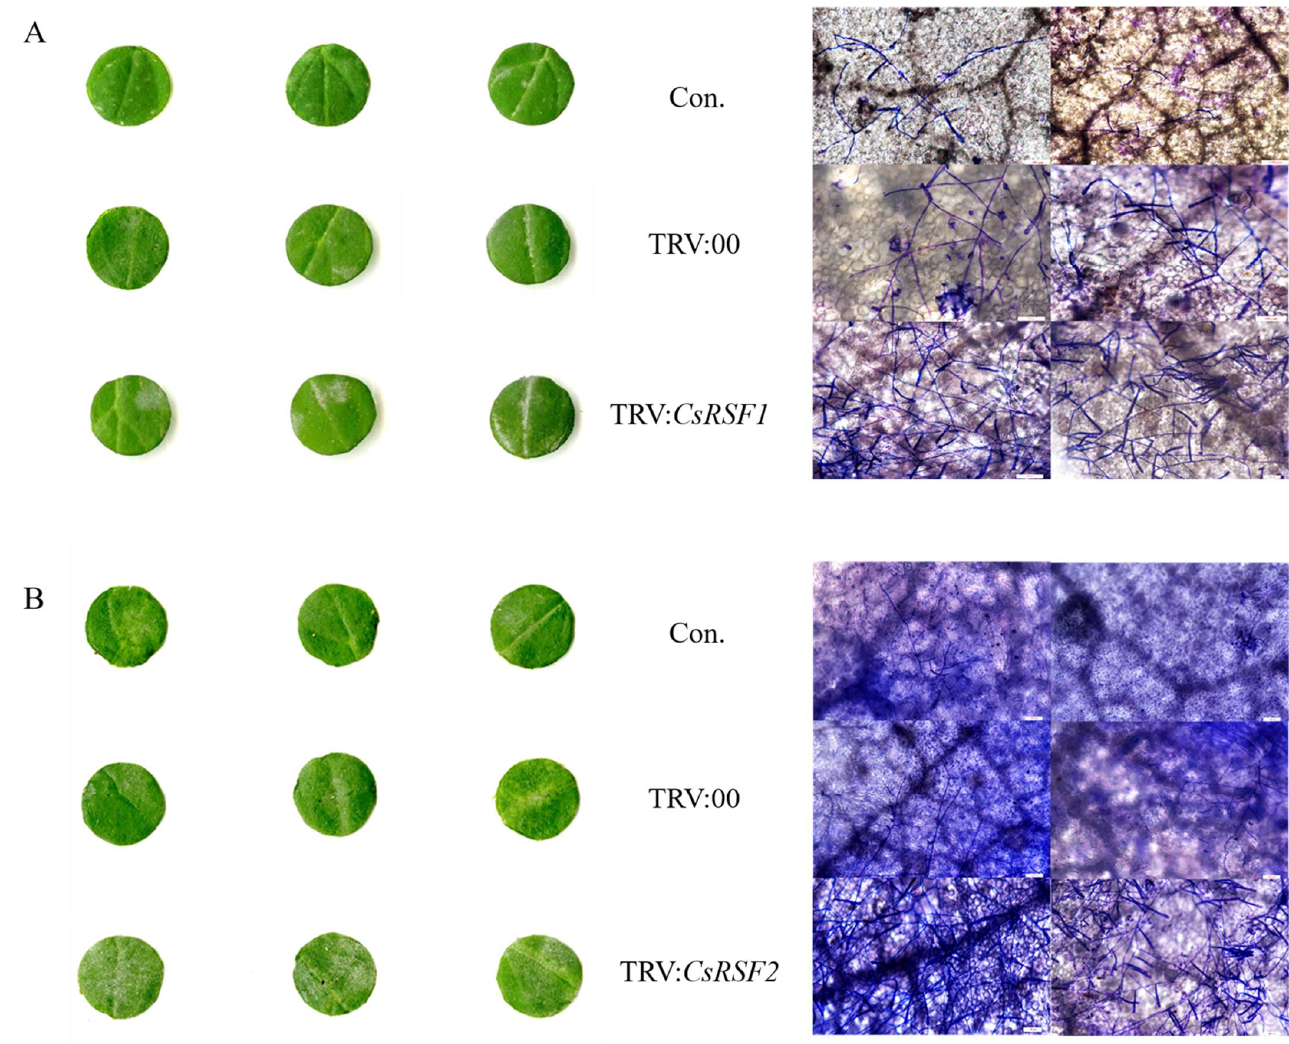
Figure 6. Identification disease-resistance of CsRSF1 / CsRSF2 - silencing plants after S. fuliginea infection. ( A ) Phenotypic analysis and Coomassie brilliant blue staining to examine CsRSF1 transient silencing cucumber cotyledons after S. fuliginea infection. ( B ) Phenotypic analysis and Coomassie brilliant blue staining to examine CsRSF2 transient silencing cucumber cotyledons after S. fuliginea infection. Con. indicates non-injected plants, TRV:00 indicates TRV:00-injected plants, TRV: CsRSF1 / CsRSF2 indicates silencing plants. Bars = 100 µm. Table 1. Disease index investigation for CsRSF1 transient silencing cucumber cotyledons after S. fuliginea infection.